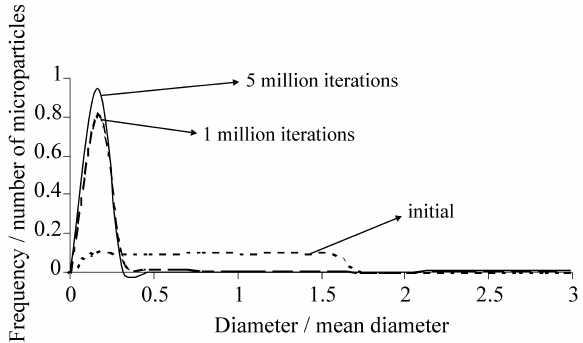
Figure 2. The result of action of w